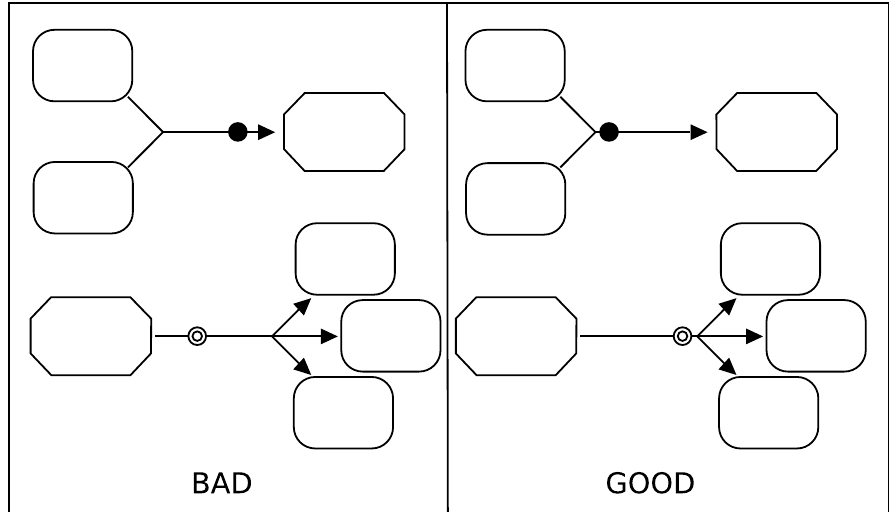
Figure 4.7: Branching points should be close to association and dissociation